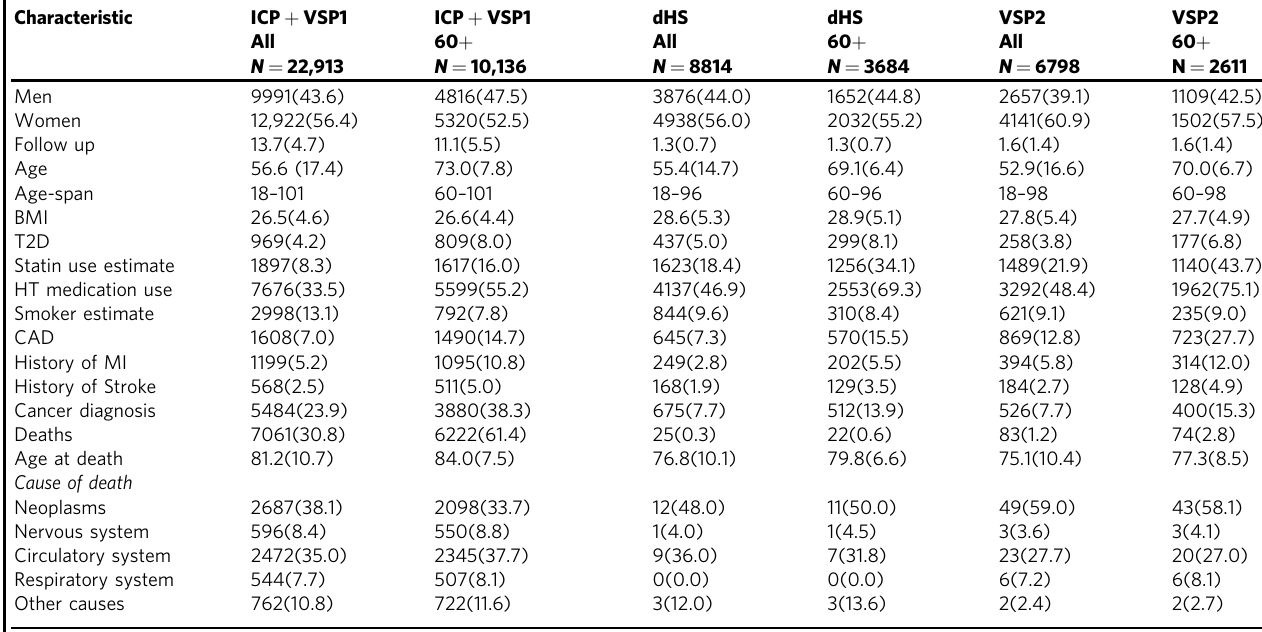
Table 1 Characteristics of all study participants by age and sample sets.